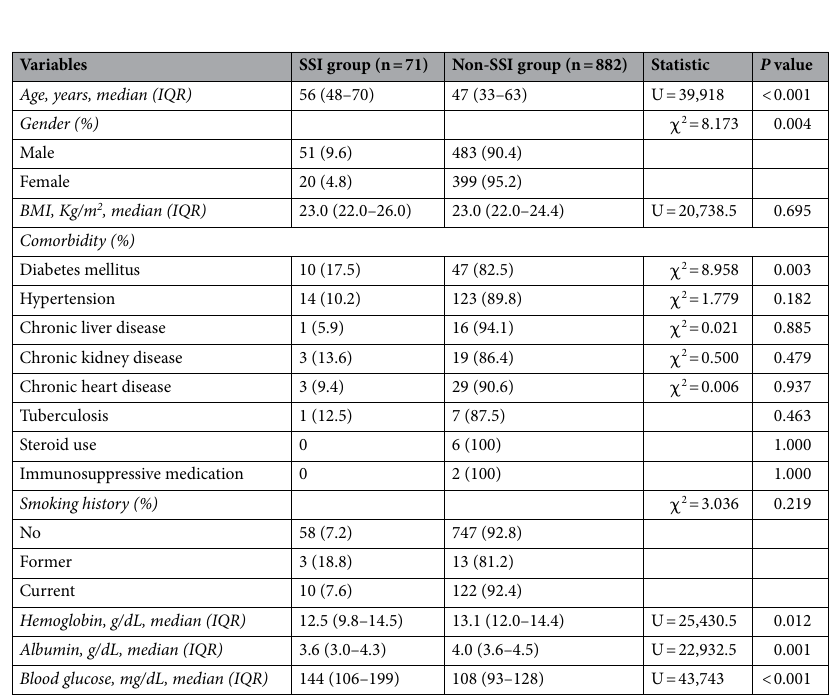
Figure 1. Patient flow chart.